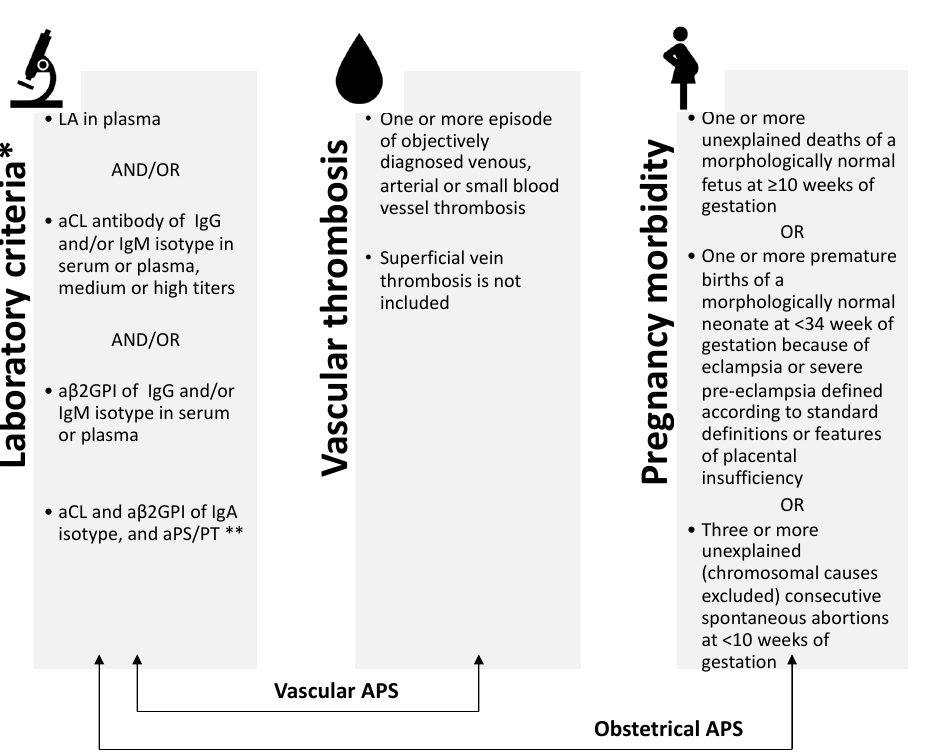
Figure 1. Classification criteria of antiphospholipid syndrome. LA, lupus anticoagulant; aCL anti-cardiolipin antibodies; a β 2GPI, anti-beta-2-glicoprotein I antibodies; aPS/PT, phosphatidylser- ine/prothrombin complex antibodies; APS, antiphospholipid syndrome. * detected on two or more occasions at least 12 weeks apart. ** clinical relevance is currently debated.